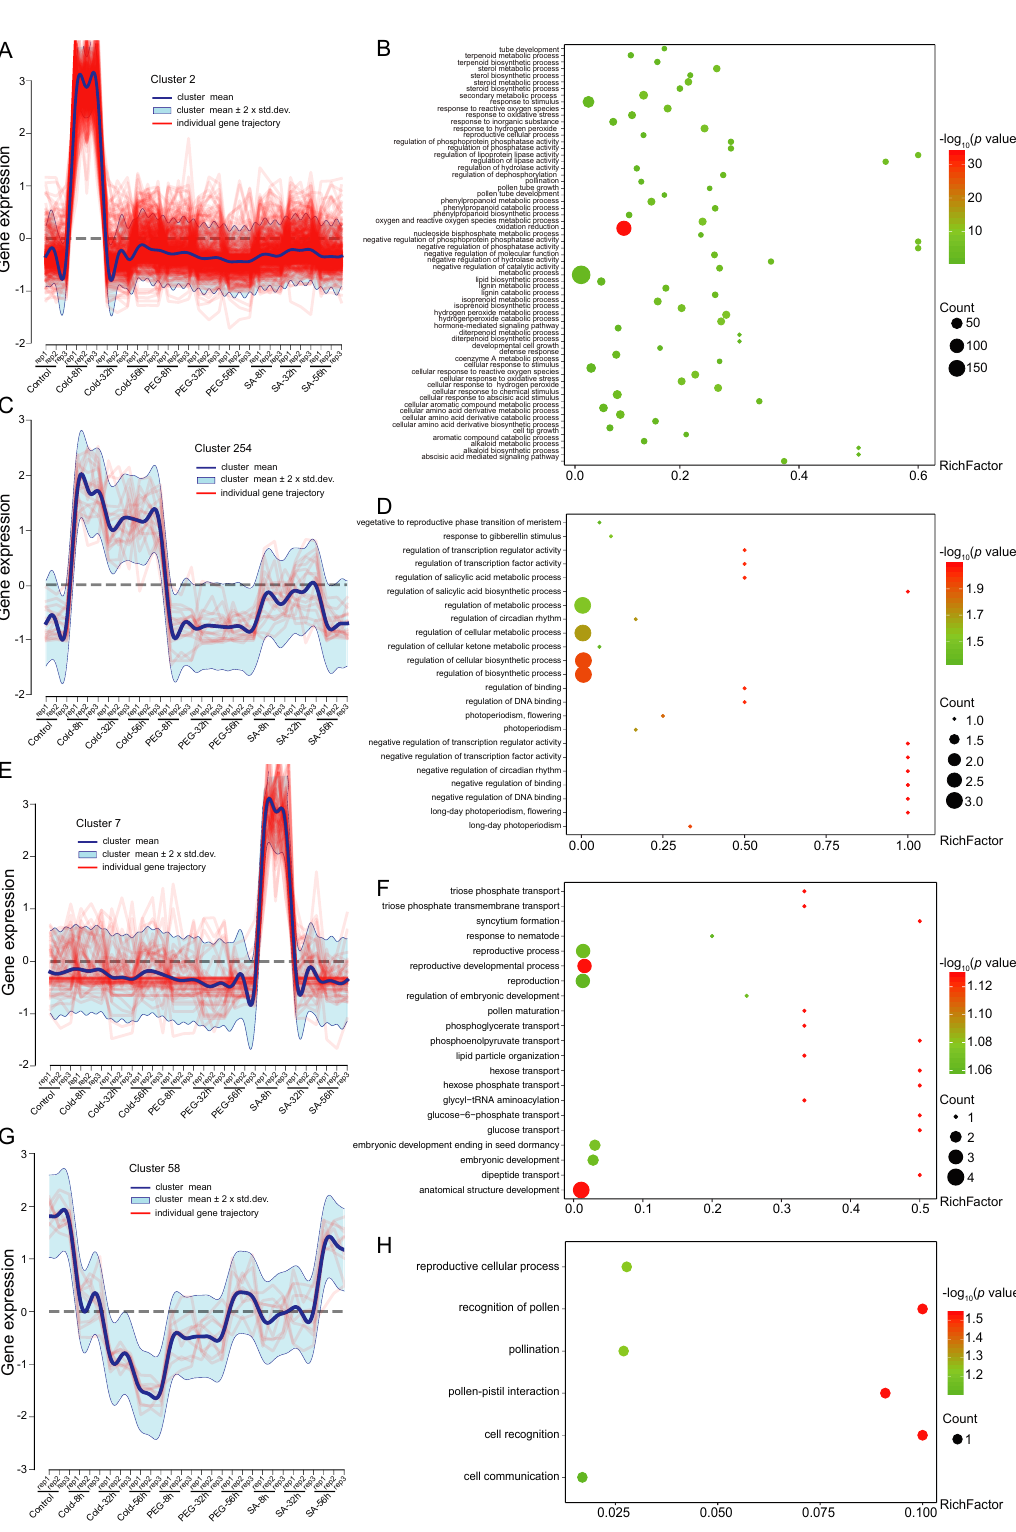
cluster mean cluster mean ± 2 x std.dev. individual gene trajectory